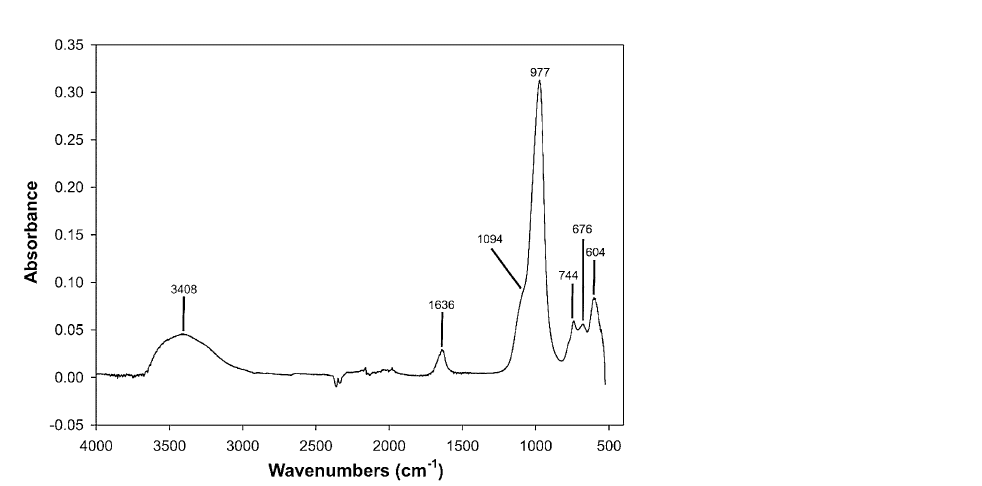
Figure 4. SEM image of Na-P 1 zeolite crystals obtained at 91 h (65 °C) ( a ) and at 54 h (100 °C) ( b ) of the synthesis runs.